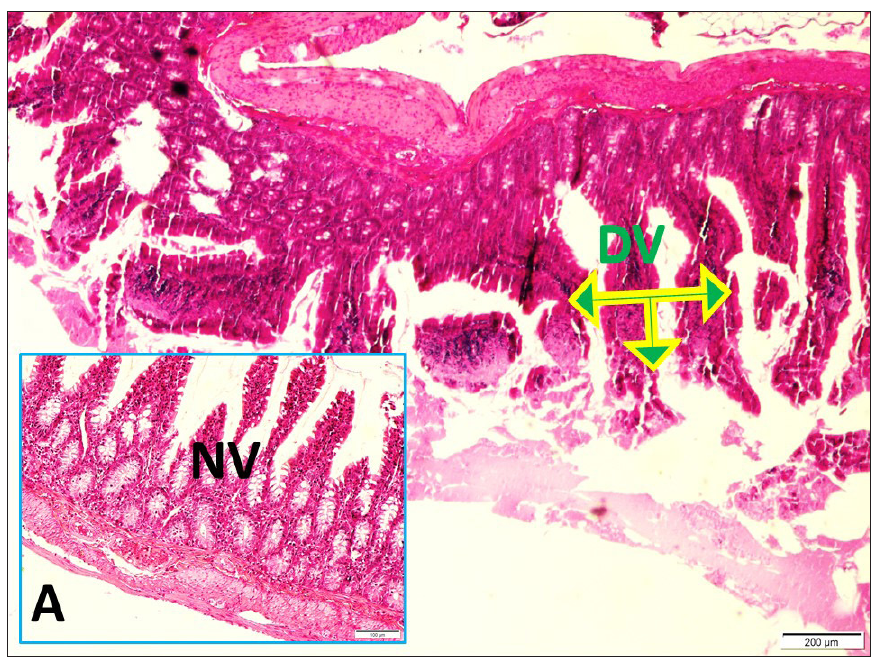
Figure 3. Histological view of the normal intestinal villi (NV) (LM, H&E, x10/A) and degenerated villi (Dv/ LM, H&E, x4/B) of a SHAM animal